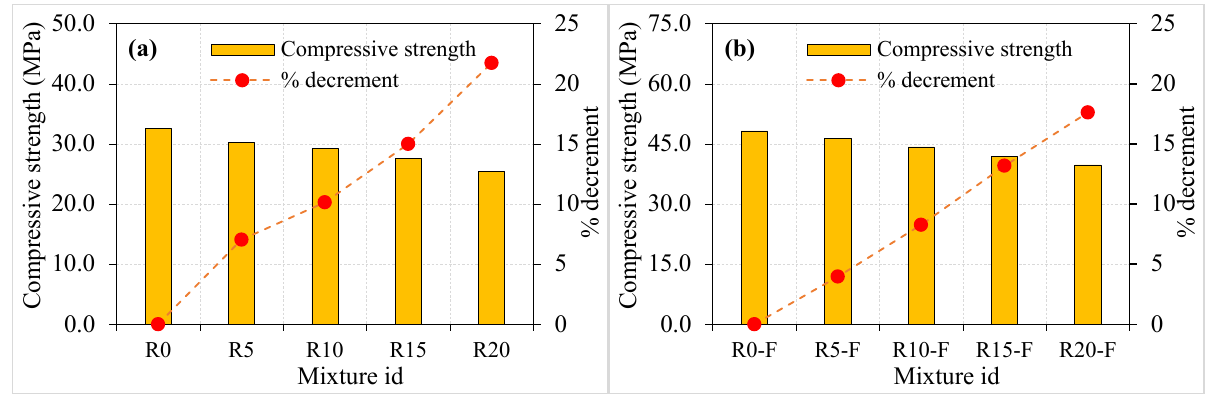
Figure 5. Compressive strength of specimens ( a ) without fibre ( b ) with fibres.